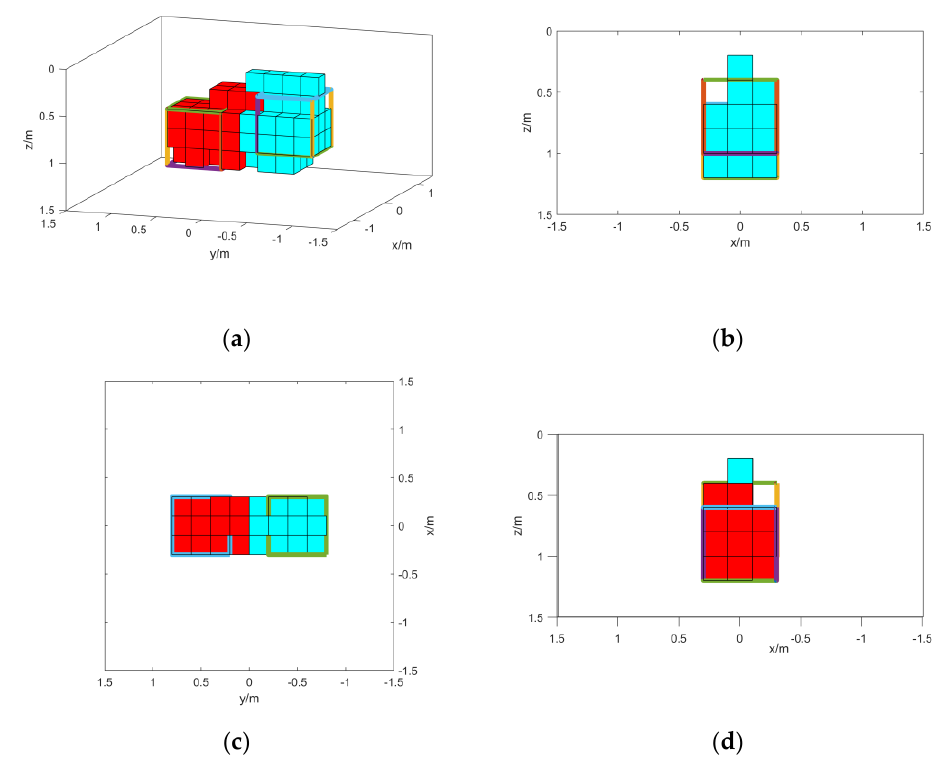
Figure 8. ( a ) Method 3 inversion results; ( b ) right-side view of method 3 inversion results; ( c ) top view of method 3 inversion results; ( d ) left-side view of method 3 inversion results. Table 4. Root mean square error between inversion results and measured data under different meth- ods.